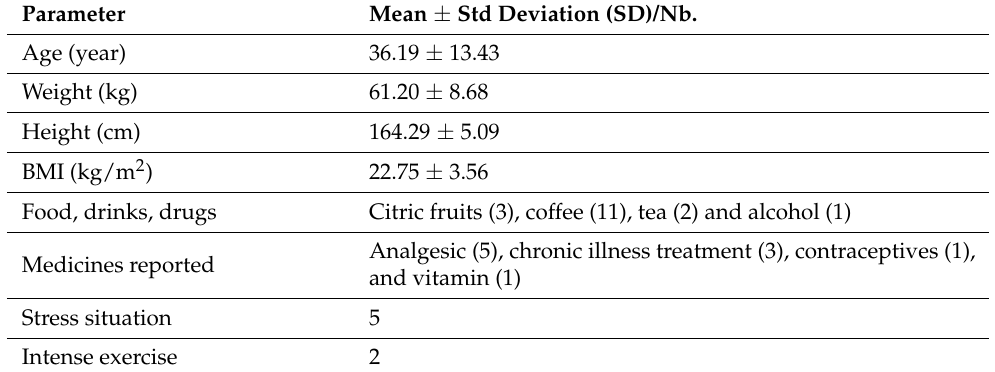
Table 2. Characteristics of women